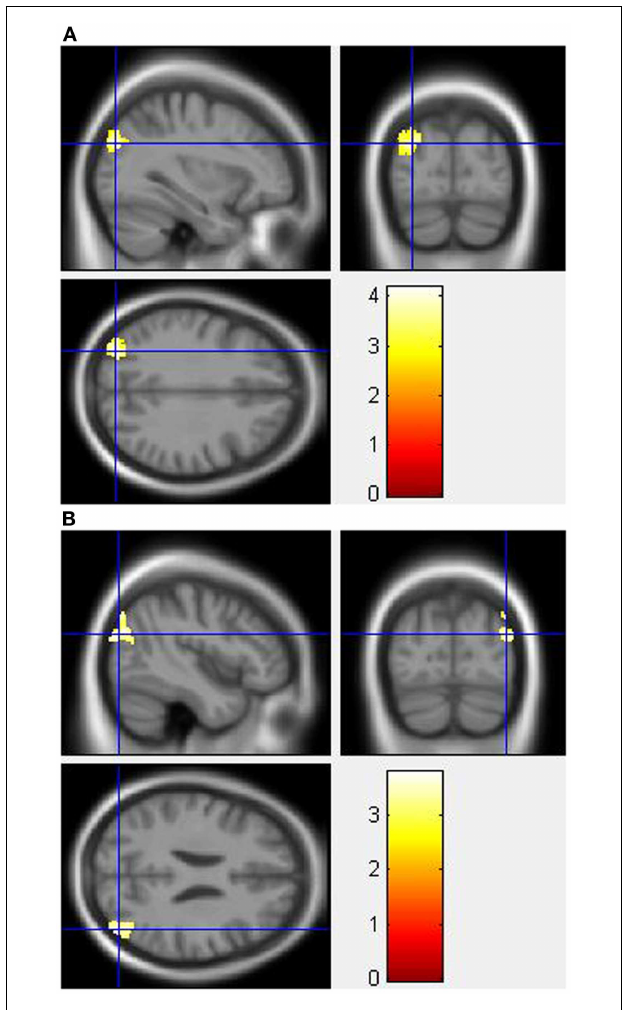
FIGURE 5 |Whole-brain 2 × 2 between-subjectANOVA results for the Stroop effect condition showing post- minus pre-drug “control MPH” > “MA MPH” group differences in activation of: (A) the left middle occipital gyrus [peak voxel MNI co-ordinates (mm): ( − 32, − 82, 30); T 29 = 4.18, p < 0.05 cluster-corrected], and (B) the right middle occipital gyrus [peak voxel MNI co-ordinates (mm): (45, − 80, 24); T 29 = 3.79, p < 0.05 cluster-corrected] .The scale represents the color (from red to yellow) of the cluster corresponding to the increasing t -statistic.The structural image represents the IXI550 average normal brain which has been registered to the MNI152 space with corresponding inferior–superior